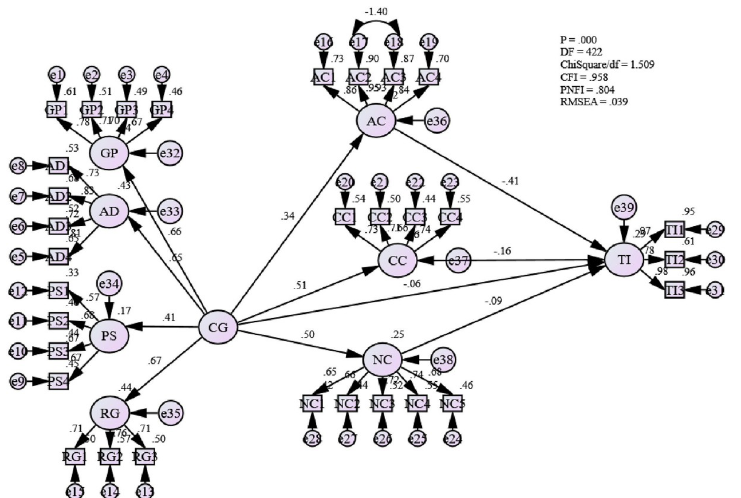
Fig 8. Fit indices and parameter estimates of hypothesized